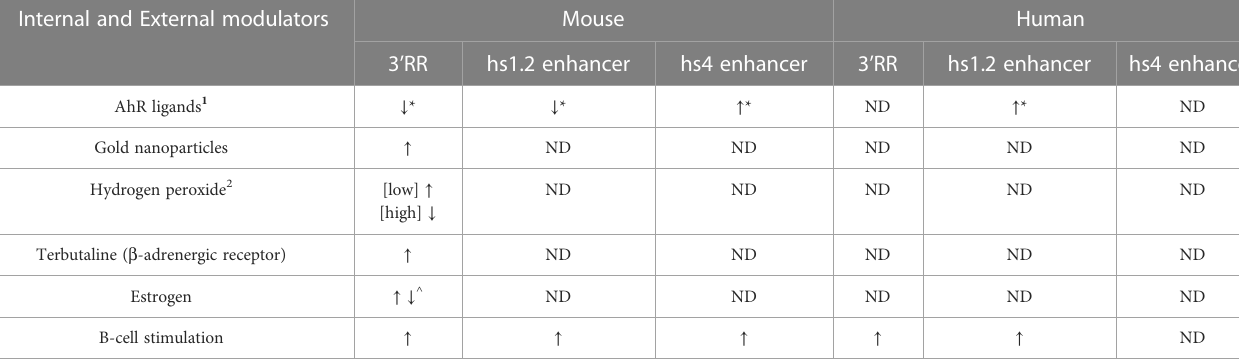
TABLE 3 Internal and external modulators of mouse and human 3 ’ RR and its enhancers. Internal and External modulators